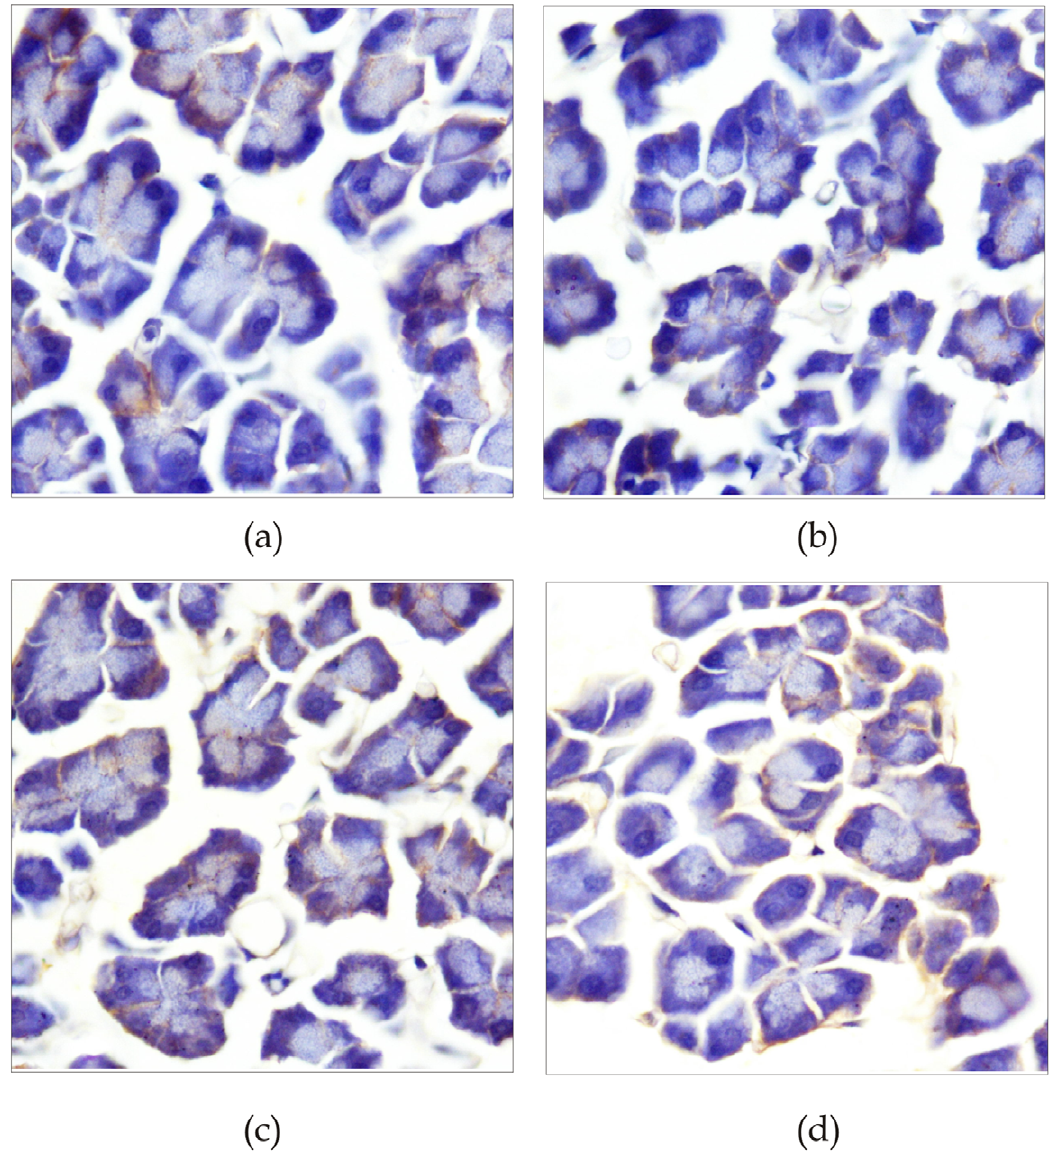
Figure 7. Immunohistochemical analysis of rat pancreas sections exposed to anti-PCFT and anti-RFC antibodies showing relative localization of PCFT (a&b) and RFC (c&d) protein. Figures (100x) shown are representative of each group.